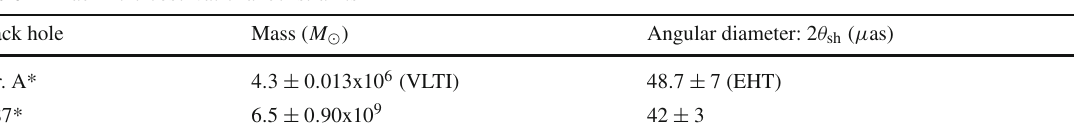
Fig. 4 Shadow observables associated with the upper left panel of Fig.3. Shown here are shadow radius (upper-left panel), angular diameter in μ as for M87* (upper-right panel), distortion parameter (lower-left panel), and energy emission rate (lower-right panel) Table 1 Black hole observational constraints